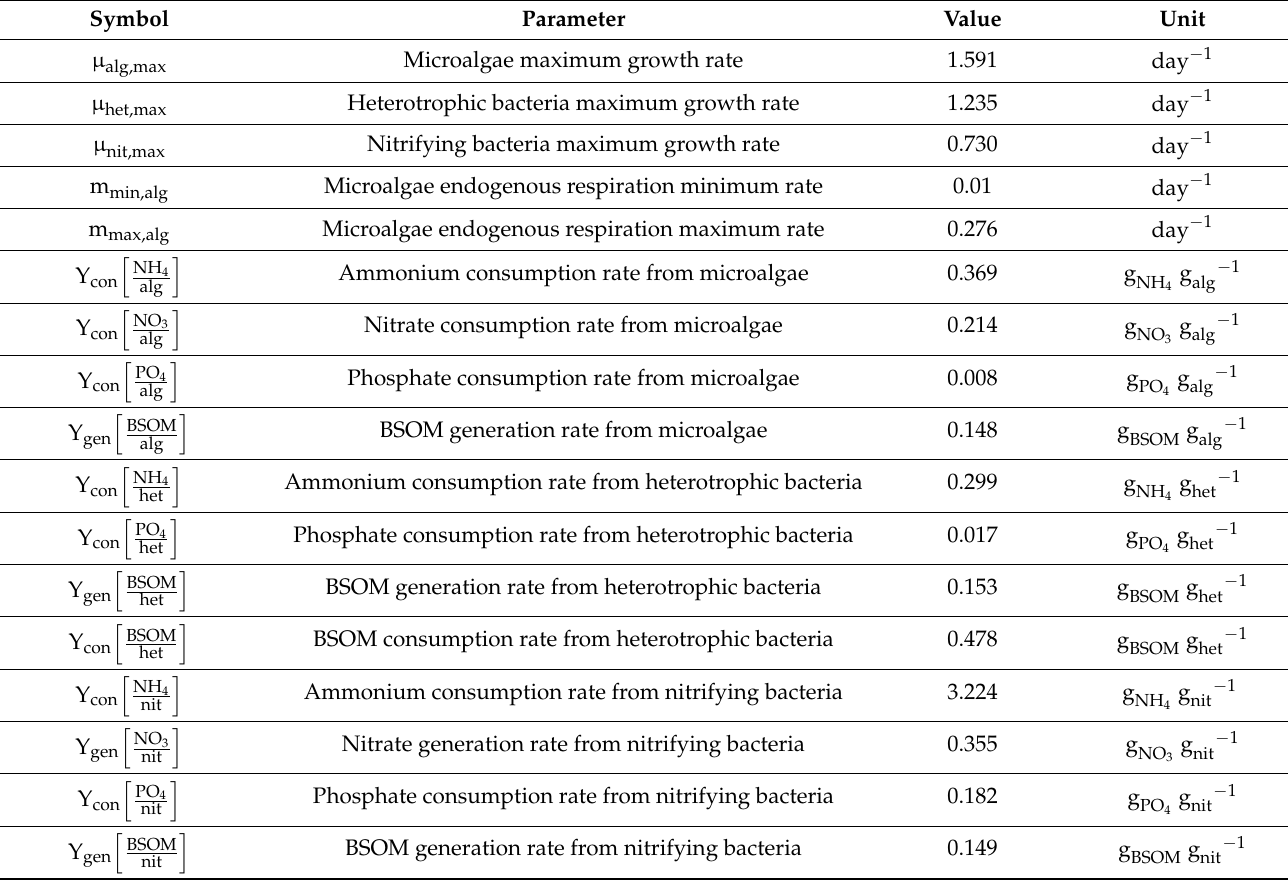
Table 2. Calibration parameters for the ABACO